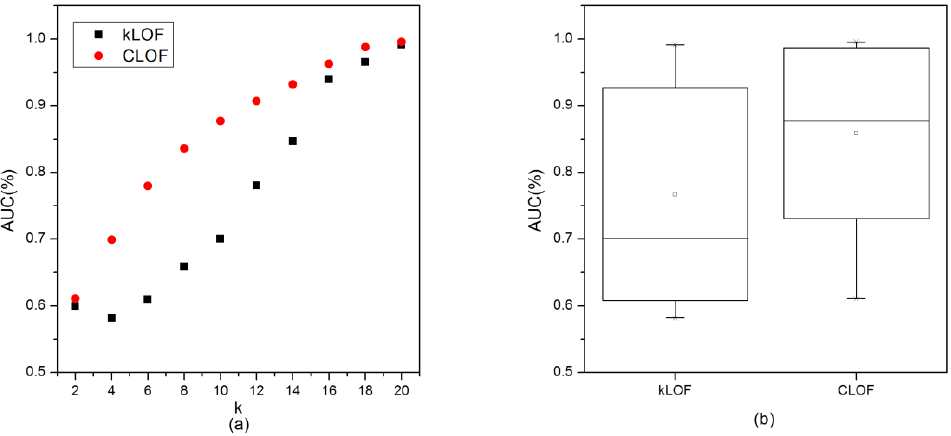
Figure 11. AUC values of kLOF and CLOF methods on KDD Cup 1999 dataset with different k related to t and the box plots for kLOF and CLOF: ( a ) the AUC values of kLOF and CLOF methods; ( b ) the box plots for kLOF and CLOF methods.